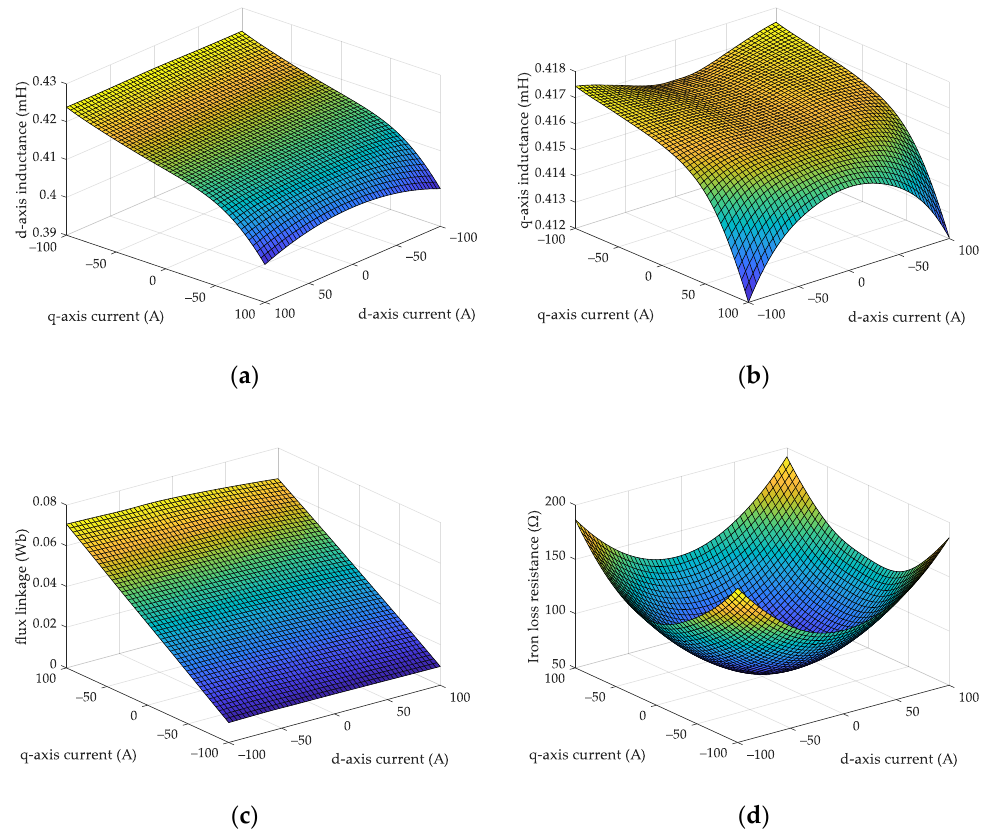
Figure 2. ( a ) Variations curve of the direct axis inductance with the d-q axis current; ( b ) Variations curve of the quadrature axis inductance with the d-q axis current; ( c ) Variations curve of the flux linkage of the permanent magnet with the d-q axis current; ( d ) Variations curve of the iron loss equivalent resistance with the d-q axis